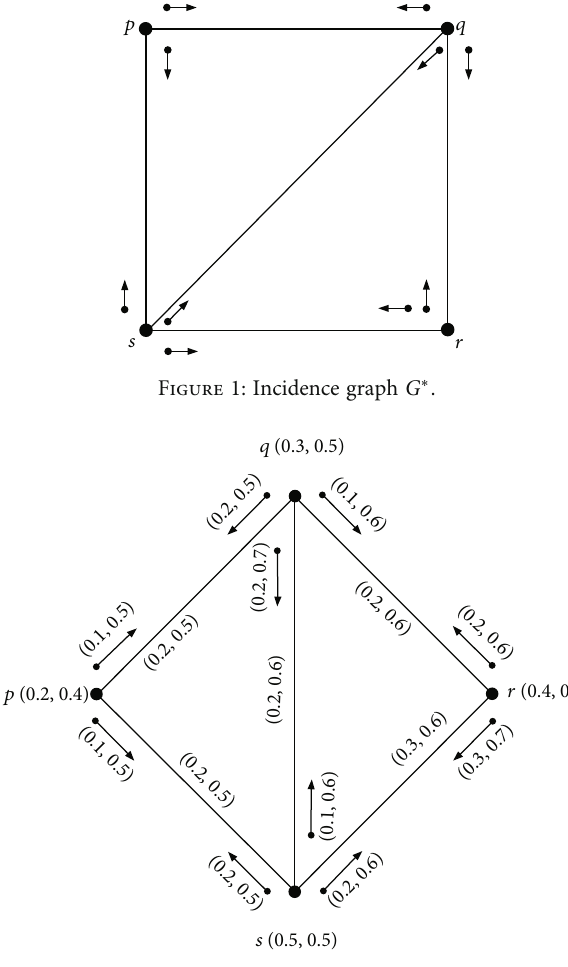
Figure 2: Vague incidence graph G